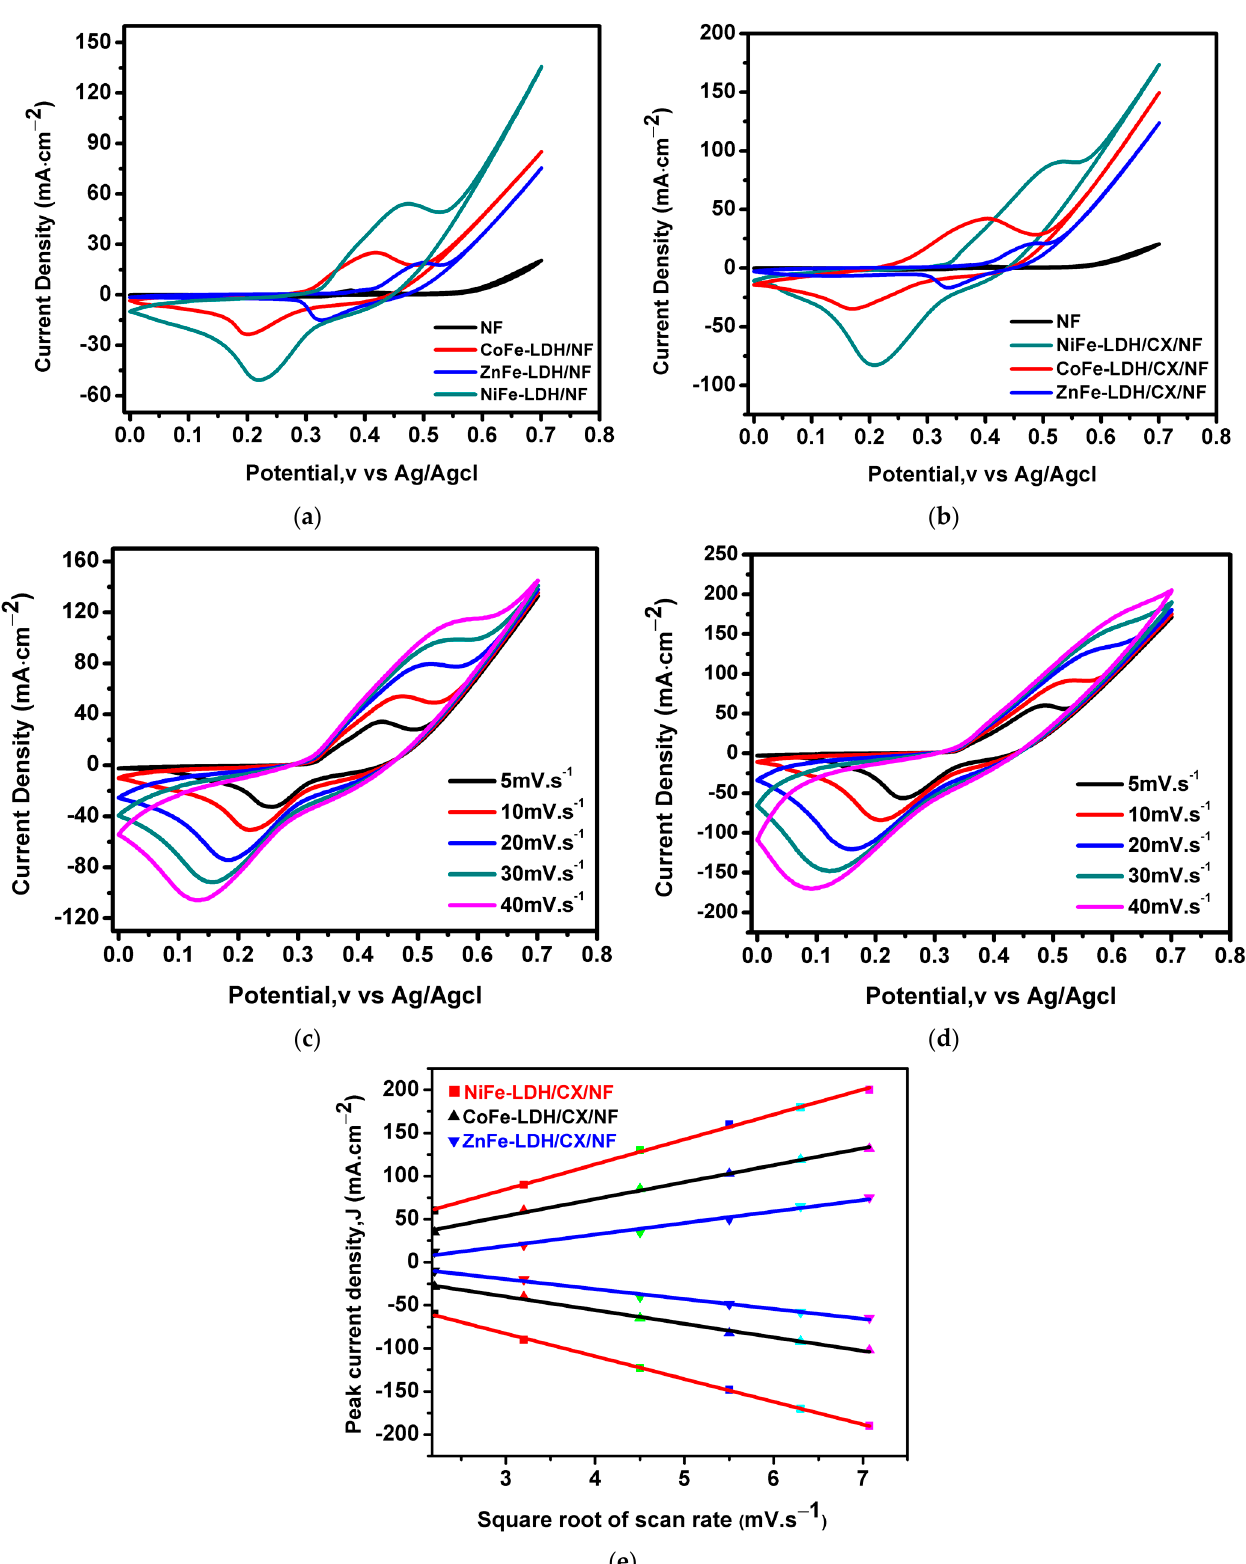
Figure 6. CVs at 1M KOH of ( a ) LDHs/NF at 10 mV/s, ( b ) LDHs/CX/NF at 10 mV/s, ( c ) NiFe-LDH/NF at different scan rates, and ( d ) NiFe-LDH/CX/NF at different scan rates. ( e ) Linear relationship between the forward/backward anodic peak currents and the square root of the scan rate for all nanohybrids with CX.